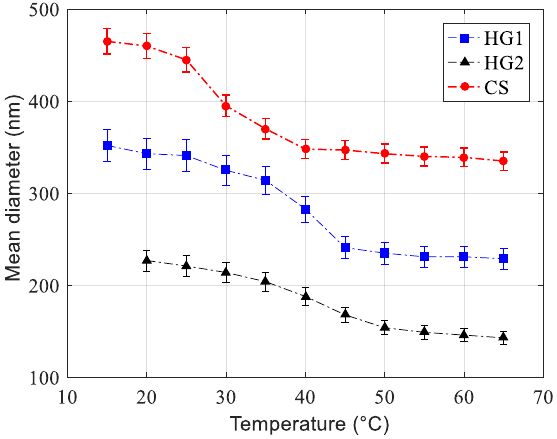
Figure 2. Hydrodynamic mean particle size of HG1, HG2, and core shell (CS) as a function of temperature in 1 mM NaCl solution.